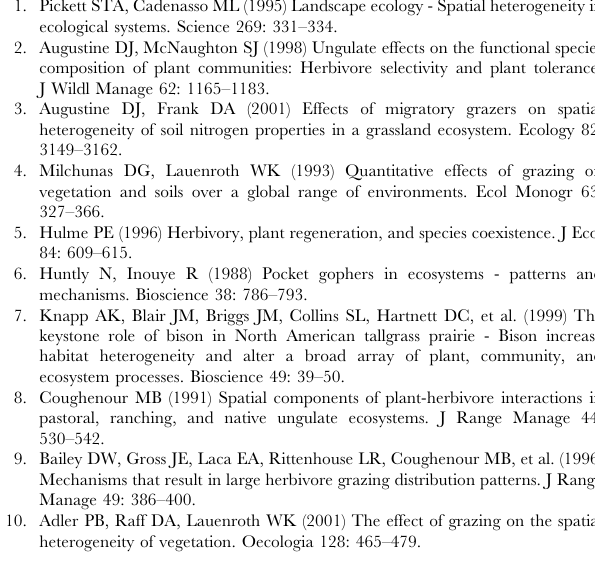
Table S3 Results of the two factor PERMANOVAs assessing multivariate differences between sites and habitats in assemblages of (a) all roving herbivorous fish, (b) browser herbivorous fish and (c) algae.